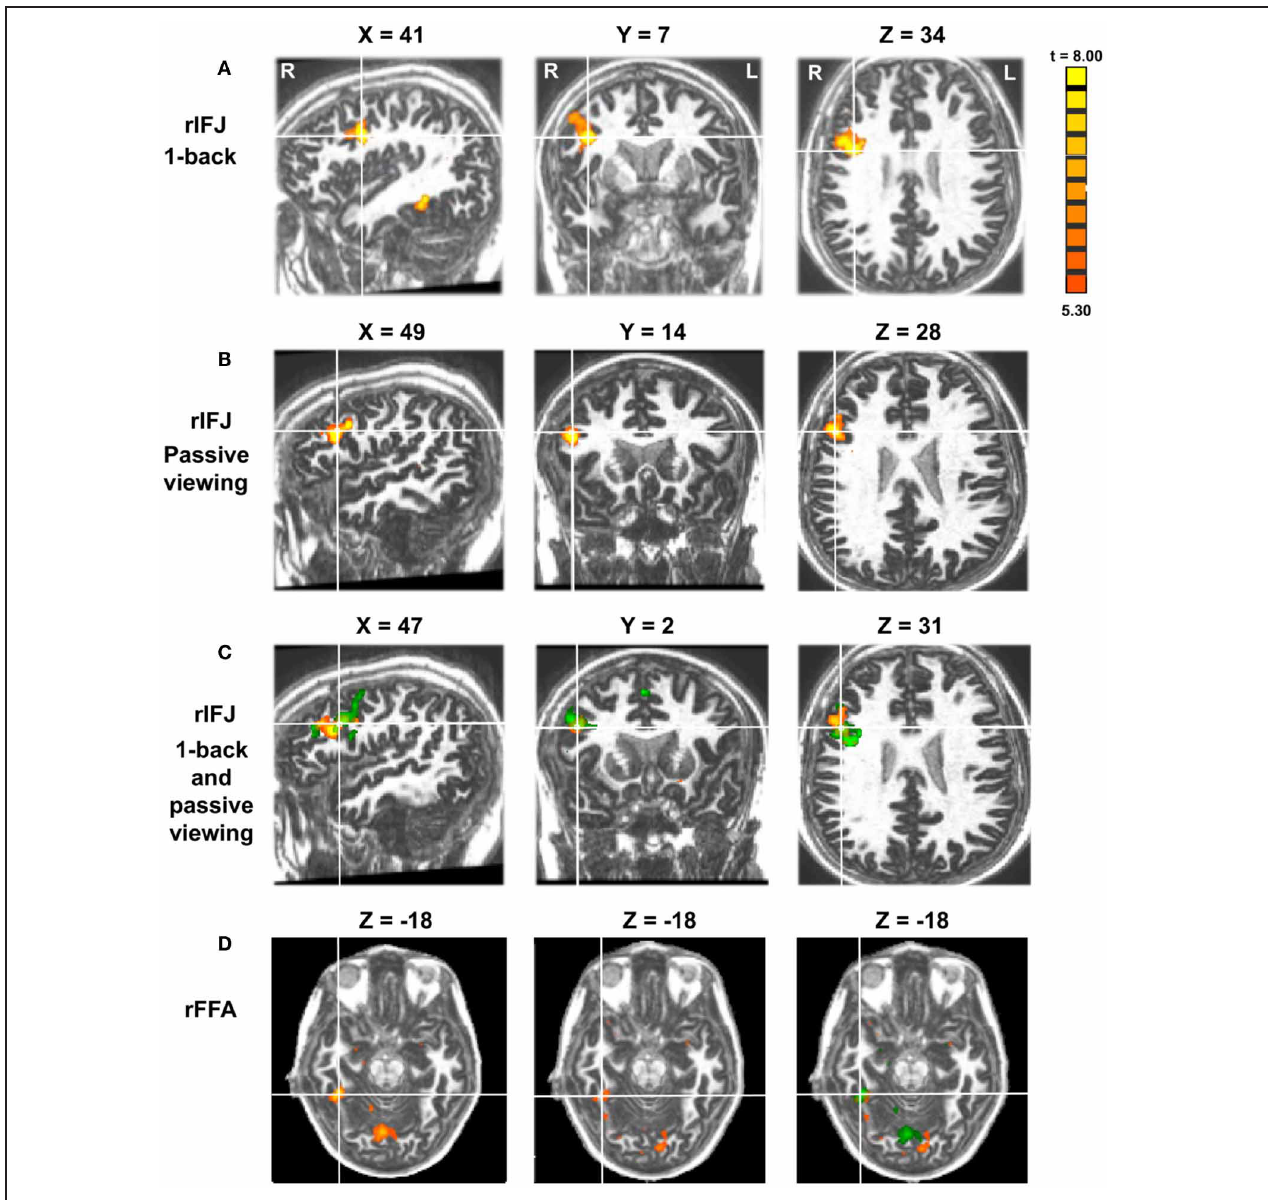
FIGURE 2 | Panel (A) shows activations in the rIFJ and the rFFA during a 1-back task. Panel (B) shows activations in the rIFJ during passive viewing. Panel (C) shows the activation overlap in the rIFJ for both tasks (green for